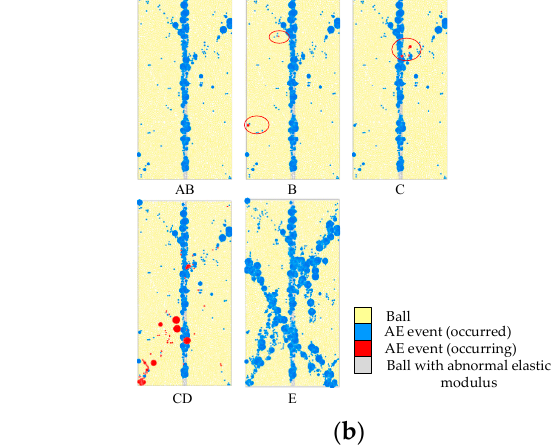
Figure 7. Numerical simulation results. ( a ) Stress and AE events of specimens with abnormal elastic modulus of 80 GPa; ( b ) AE events distribution at different stages of the specimen.